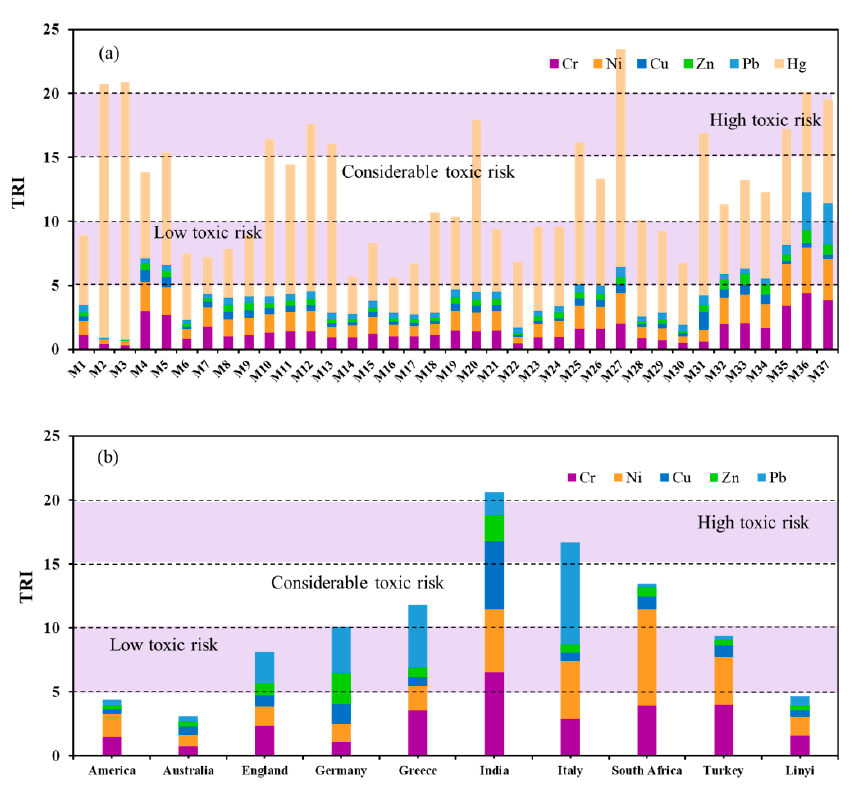
Figure 5. The toxic risk index (TRI) of heavy metals in the soil, ( a ) Linyi City, ( b ) Linyi City with other countries in the world.